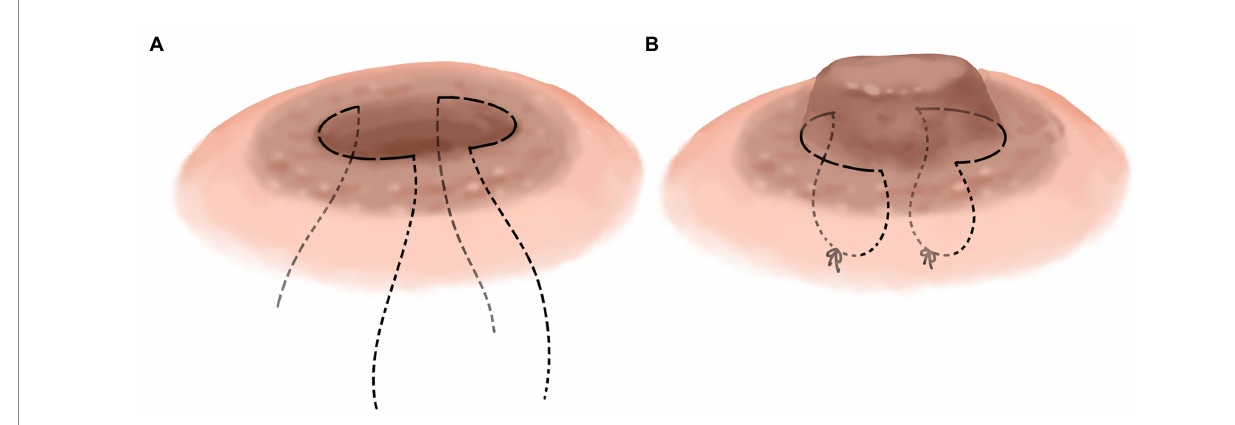
FIGURE 4 Nipple depression with imperfect development. Sew semicircular suture on both sides of the nipple root (A) , then gradually tighten the suture and tie the knot while turning the nipple outward (B) .